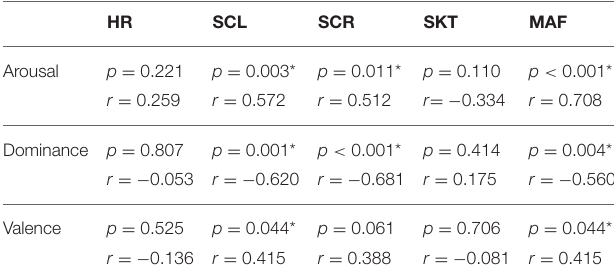
TABLE 3 | Correlations between subjective and objective